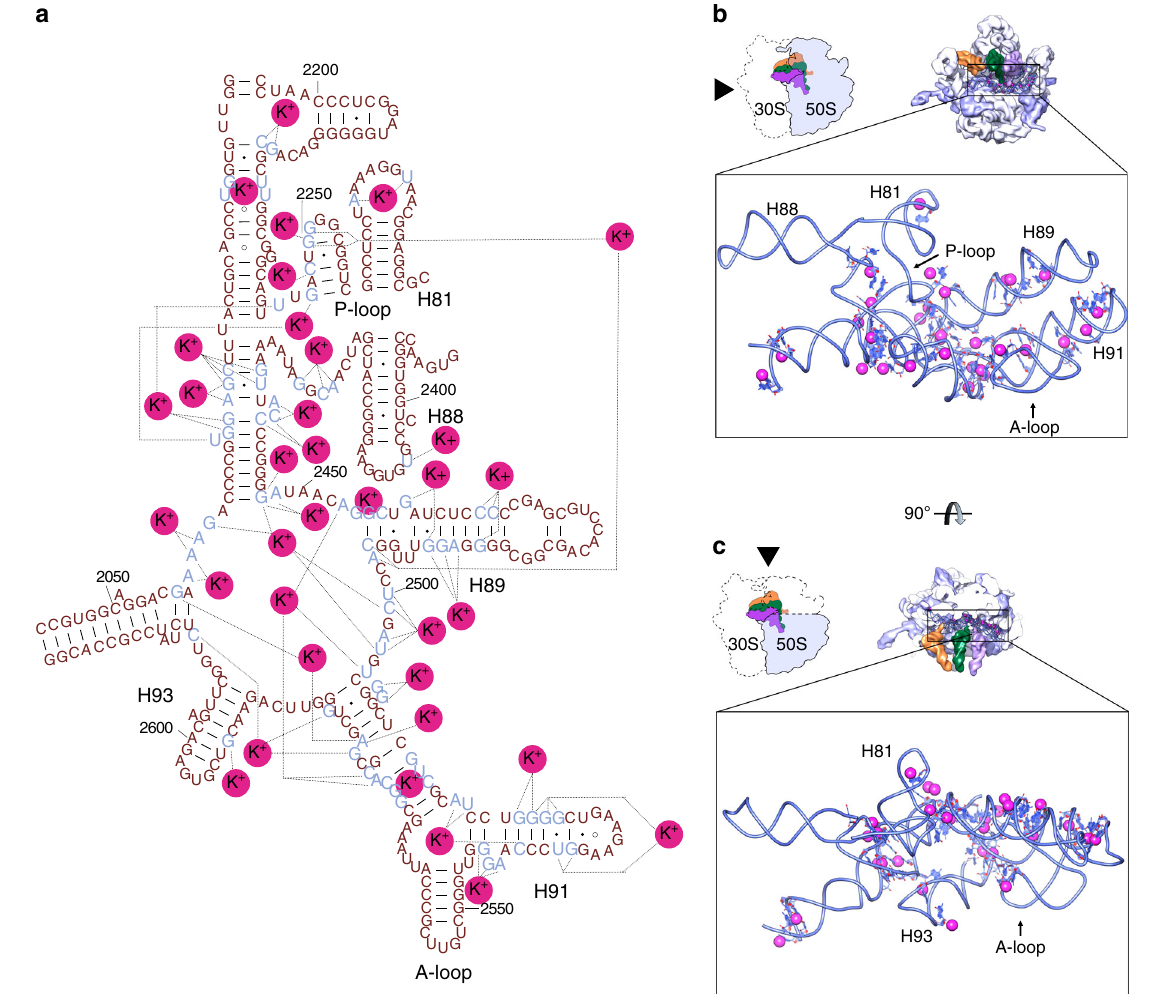
Fig. 4 Potassium ions in the peptidyl transferase center. a Mapped K + on secondary structure representation of PTC. The 23S rRNA secondary structure was adapted from H. Noller ’ s lab web site (http://rna.ucsc.edu/rnacenter/images/ fi gs/thermus_23s_2ndry.jpg link active on 04 Sept 2018). b Interface view of the 50S (23S, 5S in light blue, proteins in blue) with three tRNAs. In close up view only PTC and K + ions (with increased van der Waals radius) are shown. c Interface view of the 50S, with central protuberance omitted (colors are as in b